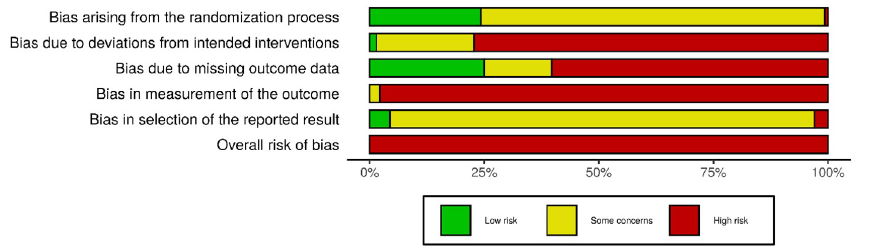
Fig 3. Risk of bias across studies. Highest–risk ratings were used for sources with outcome–level